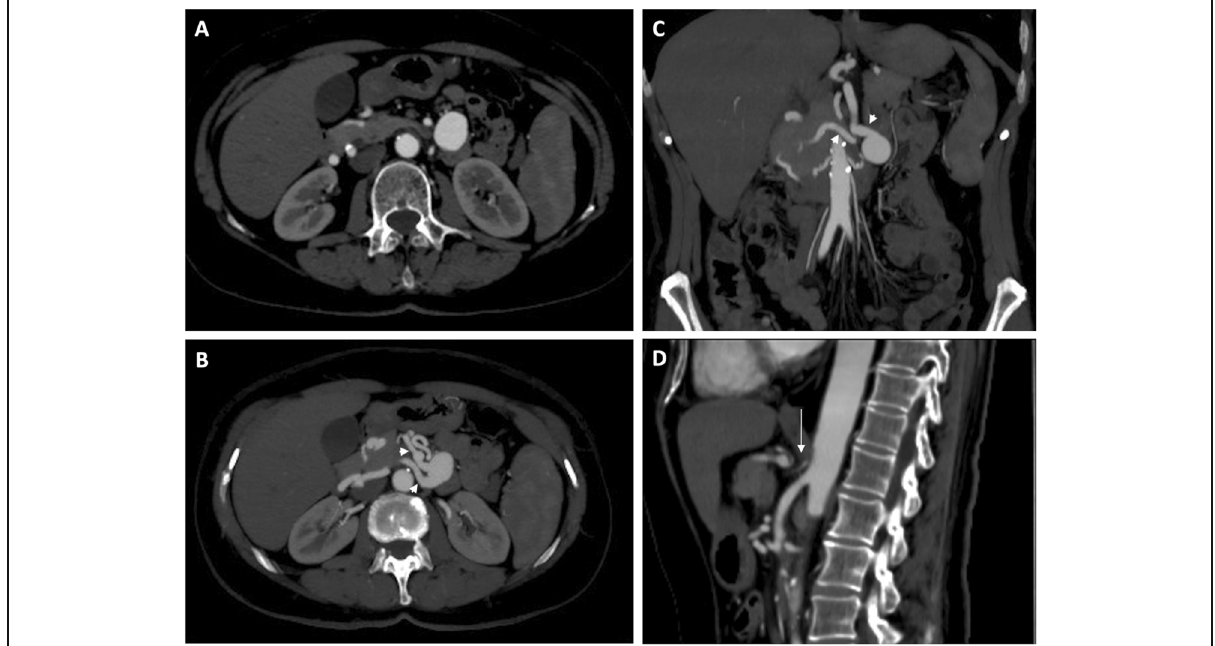
Fig. 1 CT angiogram, performed in a 58 years-old woman with a history of abdominal pain and an occasional feedback of an aneurysm of the inferior pancreatic duodenal artery. The aneurysmal sac measured 2,6 × 2,1 cm in maximum diameter ( a ) (arrowheads). Maximum intensity projected reconstruction ( b , c ) better depicted the aneurysm morphology with relatively wide neck and dilated inferior pancreatic duodenal artery (arrowheads); the sagittal reconstruction showed celiac trunk occlusion ( d , white